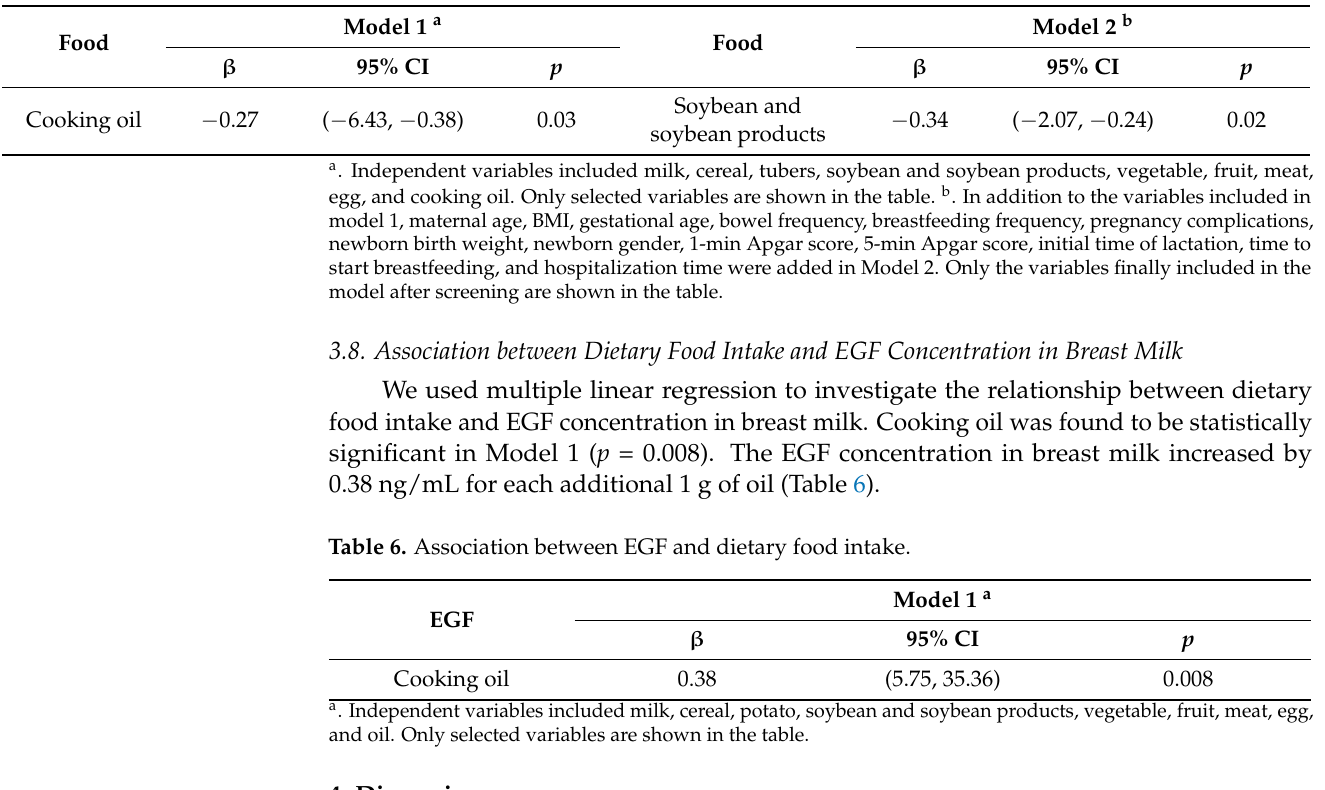
Table 5. Association between dietary food intake and the TcB value.